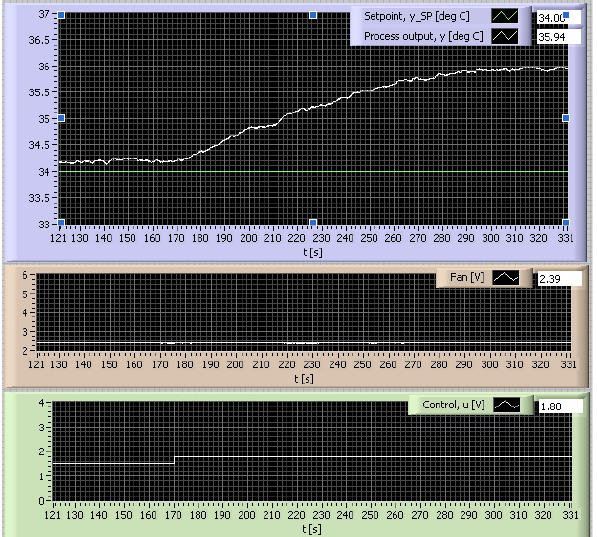
Figure 4: Skogestad’s method: Process step response. The response indicates that a proper model is “time- constant with time-delay” as given by Eq. (4).